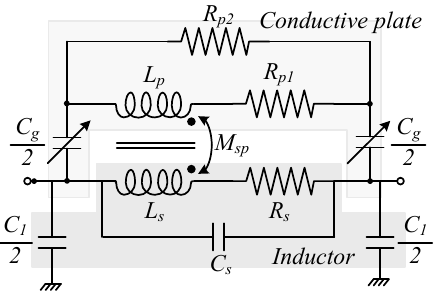
Figure 4. Lumped physical model of the variable planar inductor implemented on a FR-4 substrate with a proximity plate.